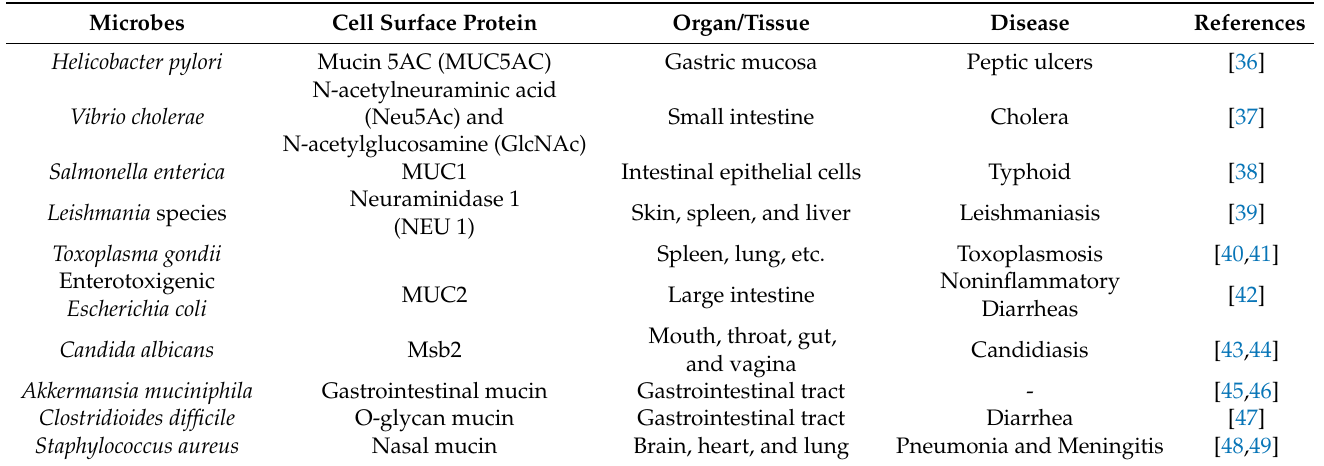
Table 1. Microorganisms and associated host cell surface protein and pathogen infection at mucosal membrane. Mucous membrane is rich in glycosylated proteins and several pathogens, such as Candida albicans , Escherichia coli , Salmonella , Vibrio cholerae , etc., exploit glycoproteins at the mucosal